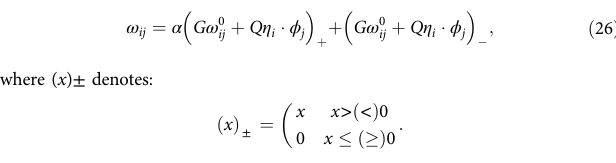
Figure 3 methods . The teaching signal was constructed using the positive com- ponent for a sinusoid with a frequency of 2Hz for quarter notes and 1Hz for half notes. Each pulse corresponds to the presence of a note and they can also be used as the amplitude/envelope of the harmonics corresponding to each note to generate an audio-signal from the network (Supplementary Audio 1). The network con- sisted of 5000 Izhikevich neurons with identical parameters as before, G = 1× 10 4 ,